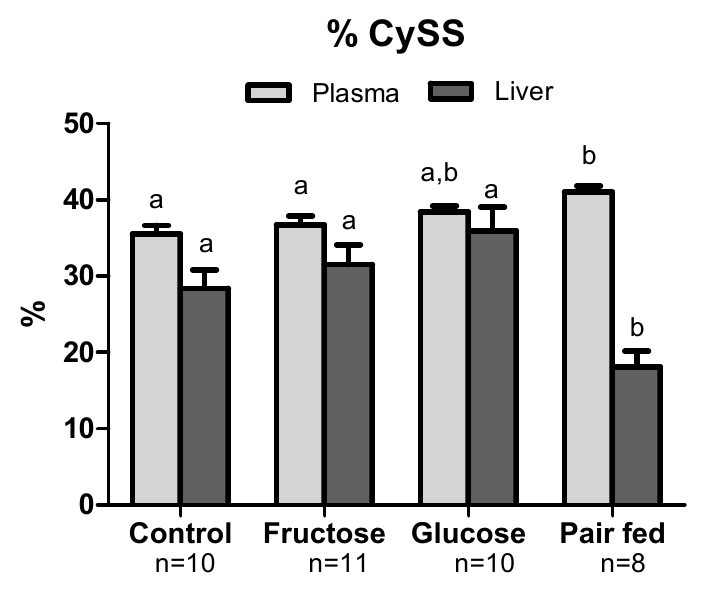
CySS) in plasma and liver. E CySS is calculated h h CySS was h